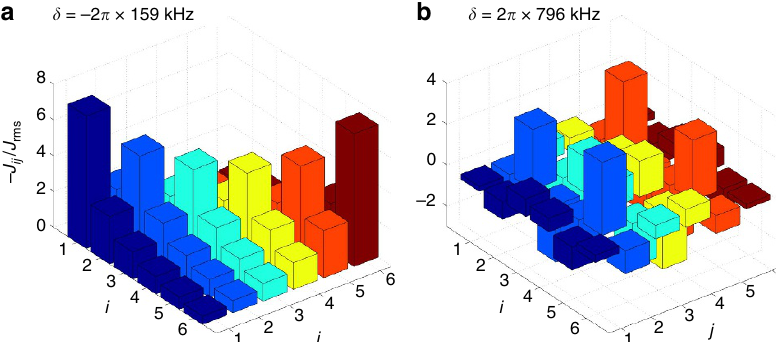
P J ij (cid:7) (cid:7) (cid:7) (cid:7) 2 ), for a system of six i 6¼ j N N (cid:3) 1 ð Þ